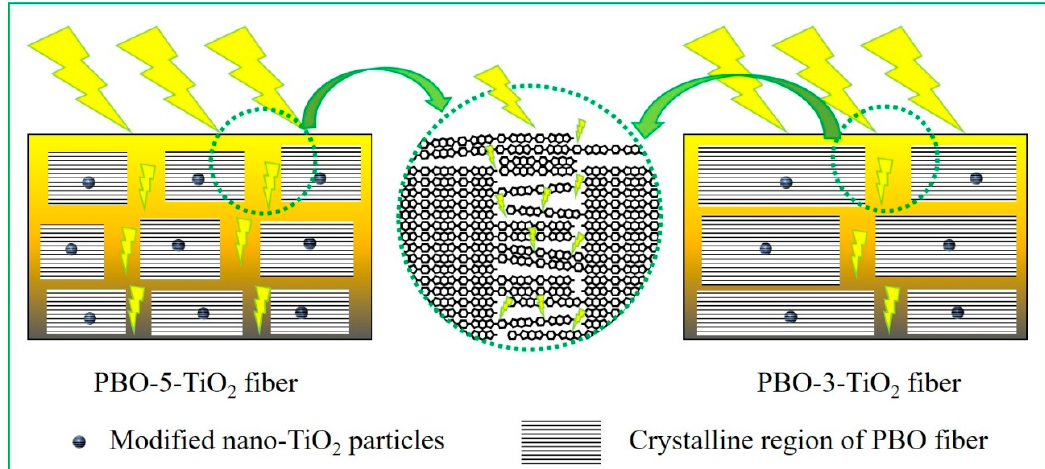
Figure 10. Schematic diagram of the influence of crystal region distribution on UV aging resistance.